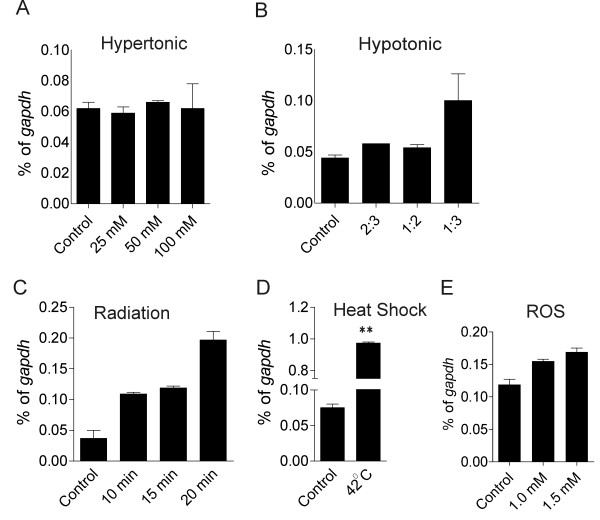
Real time RT/PCR expression of cassini in response to cellular stress. 8093 ALL cells were treated, as indicated in Methods, with (A) hypertonic medium (n = 1); (B) hypotonic medium (n = 3); (C) radiation (n = 2); (D) heat shock (n = 3); and (E) H2O2 (n = 3). Values are represented as mean ± SD of duplicate real-time RT/PCR. D **p < 0.01 heat shock versus control. Other comparisons, n.s., p > 0.05.